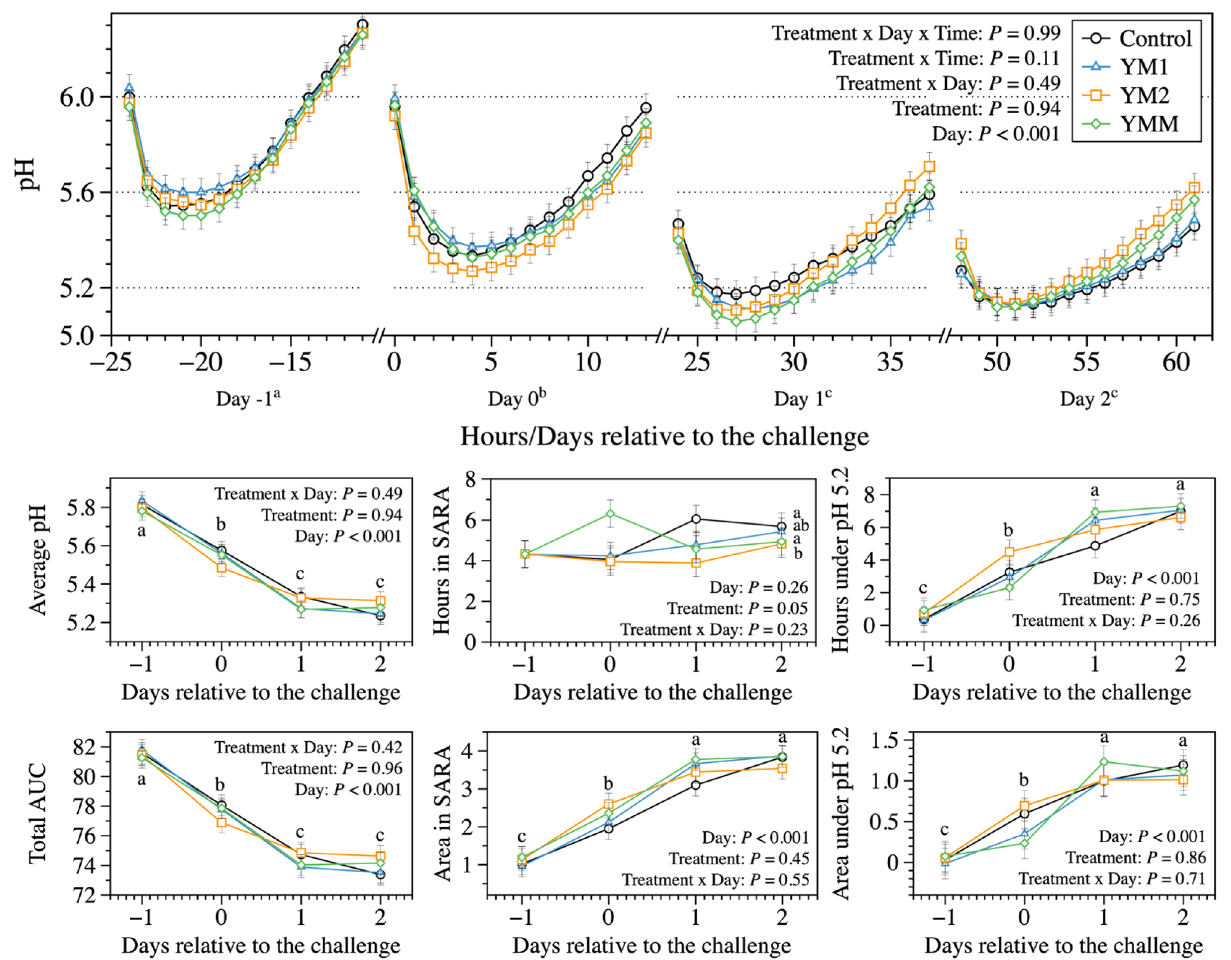
Figure 1. Dynamics of fermentation pH after the morning feeding, area under the curve (AUC), and time in SARA and below pH 5.2 on days 8, 9, 10, and 11 of each period to represents the days − 1, 0, 1, and 2 relative to the challenge; day 7 was used as a covariate to the model. All treatments had the same basal diet (1 mL of each DFM was applied per day at 1 × 10 8 cfu/mL); treatments were: Control, carrier of additives without DFM; YM1, S. cerevisiae and M. elsdenii strain 1; YM1, S. cerevisiae and M. elsdenii strain 2; YMM, S. cerevisiae and M. elsdenii strain 1 (1/2 dose) and strain 2 (1/2 dose). Statistical differences were declared at P ≤ 0.05 or as a trend to be different if P > 0.05 and <